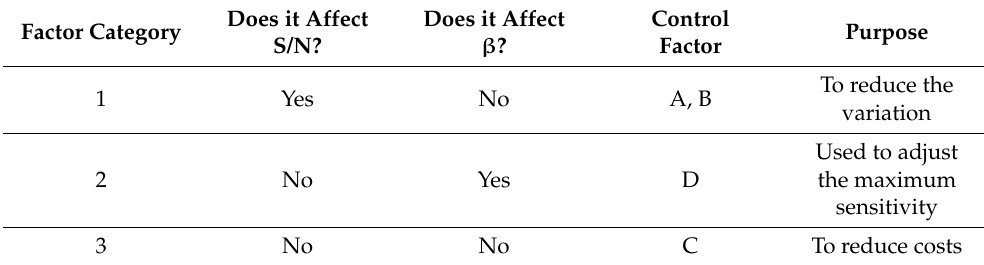
Figure 15. ( a ). Factory setting for voltage and current waveform; ( b ). optimization of voltage and current waveform by the Taguchi-Regression algorithm. Table 7. Control parameter impact